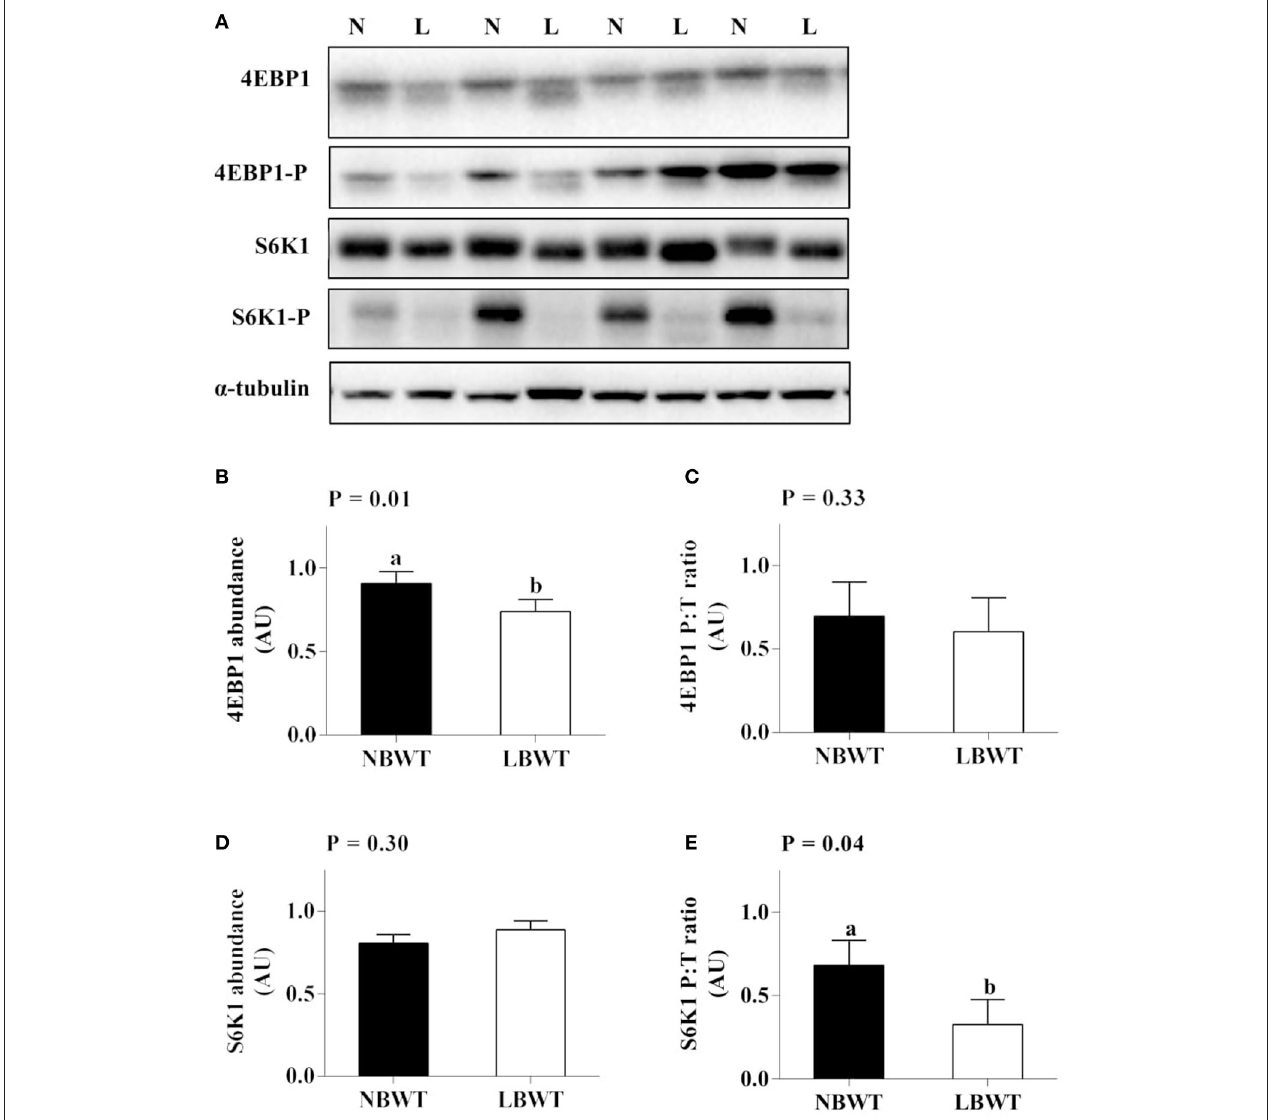
FIGURE 5 | Protein abundance and phosphorylation of 4EBP1 and S6K1 in longissimus dorsi muscle of low-birth-weight (LBWT) and normal-birth-weight (NBWT) neonatal pigs. (A) : Representative western blots from four pairs of LBWT and NBWT pigs (N, NBWT; L, LBWT). (B – E) : Protein abundance and phosphorylation of 4EBP1 and S6K1. Abundance was normalized to α -tubulin and phosphorylation normalized to the corresponding non-phospho-proteins. Results are means ± SE. n = 12. Values with different letters differ significantly ( P ≤